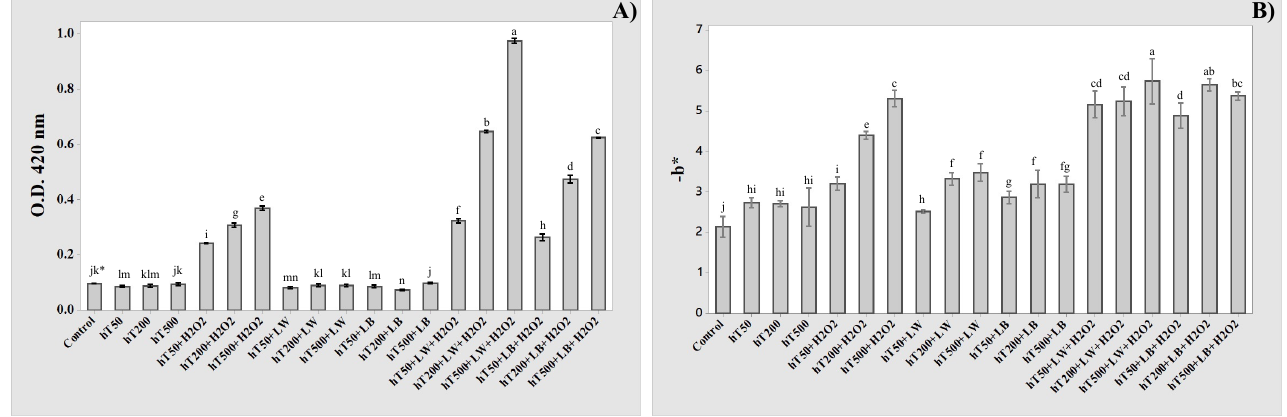
Figure 5. Effect of hydrolyzable tannins’ (hT) addition at different concentration (50, 200, and 500 mg/L), light exposure (LW, LB), and hydrogen peroxide addition (H 2 O 2 ) on optical densities at 420 nm ( A ) and b* parameter ( B ).